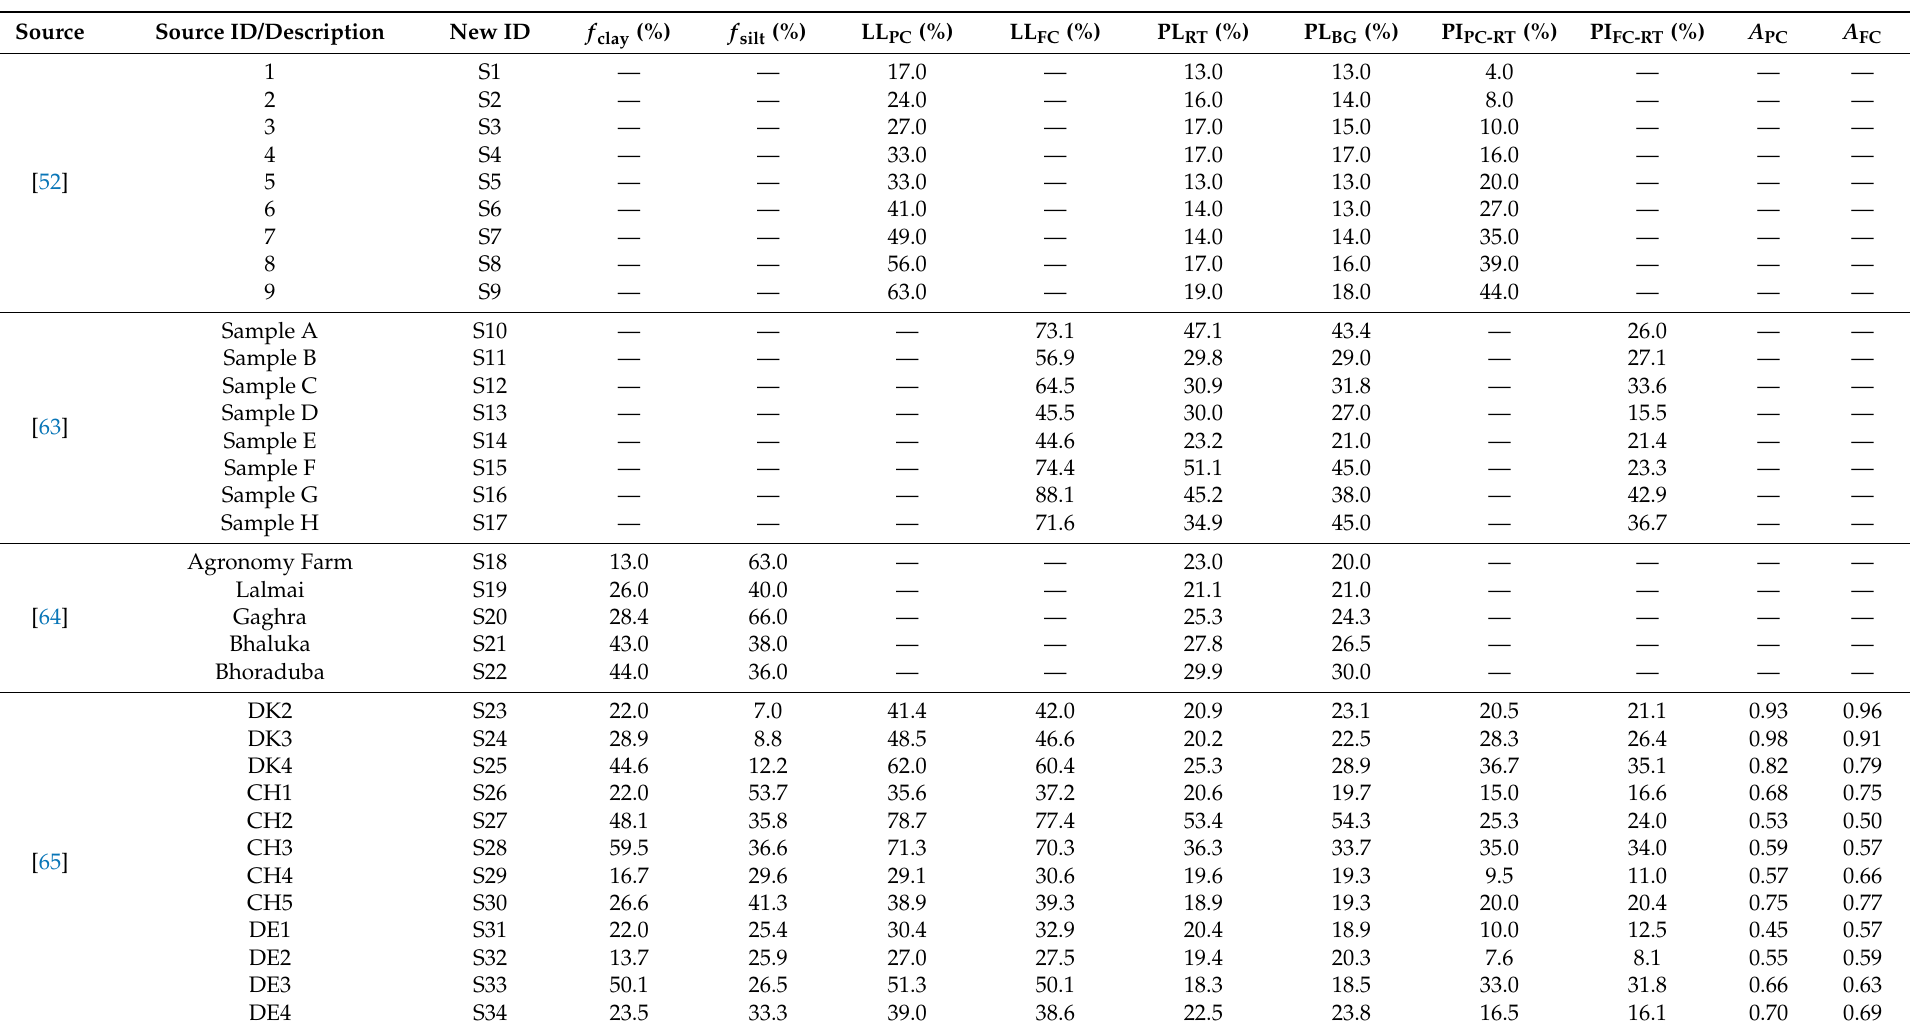
Table 1. Detailed description of the compiled database of PL RT –PL BG test